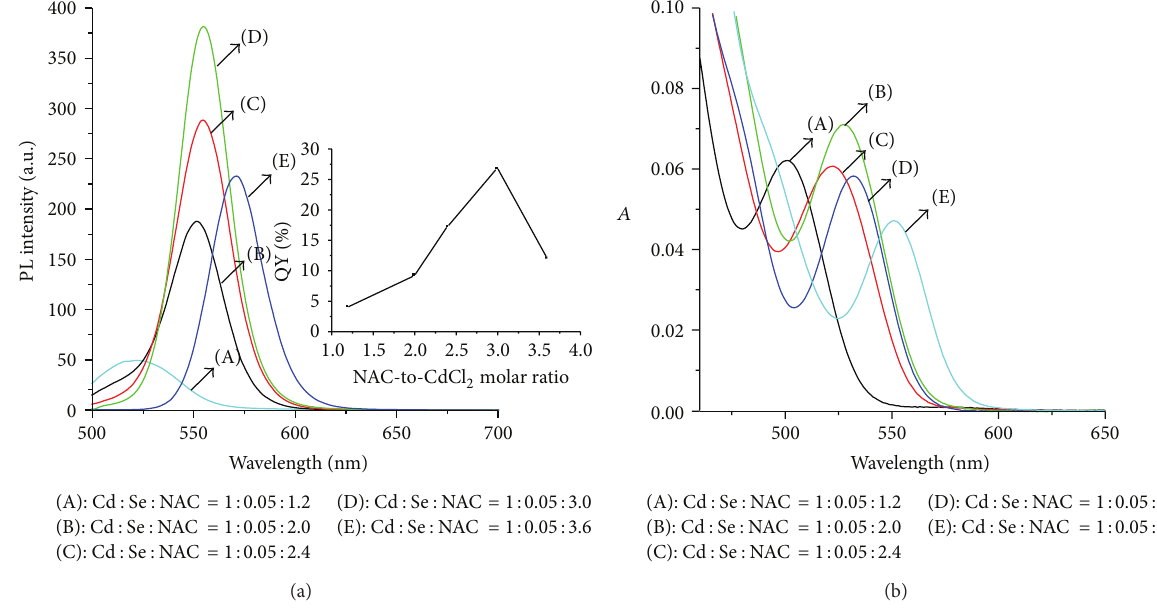
Figure 4: (a) Corrected PL spectra and (b) UV-visible absorption spectra of NAC-capped CdSe QDs grown at different 𝑛 (NAC)/1(Cd) values; the inset shows the QYs of these prepared